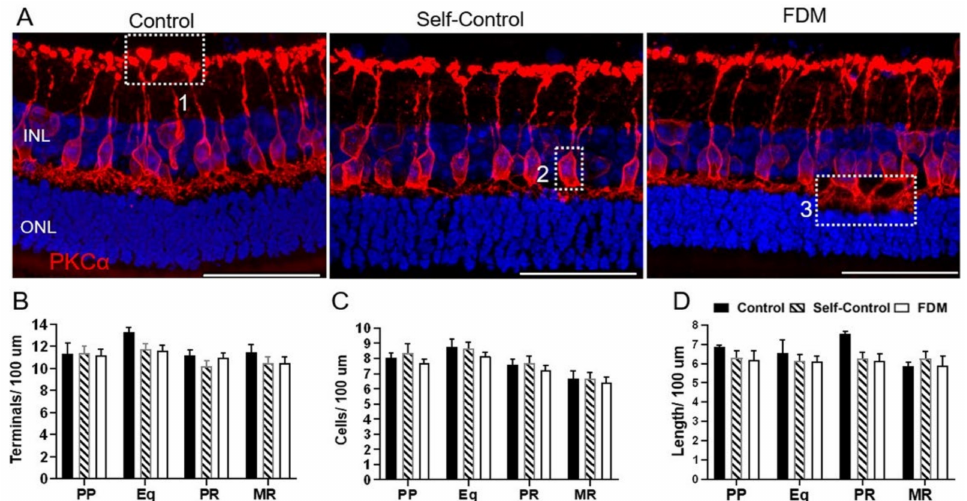
Figure 4. PKC α -bipolar cells and synapses in different groups of retinas. ( A ) Representative confocal images of PKC α labelled retinas from PP of naïve control, self-control and FDM eyes. Box 1 showing axon terminals; box 2 showing PKC α + cell body, box 3 showing PKC α + dendrites. ( B – D ) Quantitative data of PKC α + terminals ( B ), the number of PKC α + rod-bipolar cells and the length of PKC α + rod- bipolar dendrites in different retinal locations of the three groups guinea pigs. INL, inner nuclear layer; ONL, outer nuclear layer. Scale Bar: 50 µ m. Mean ± SD, n = 3~9/group.